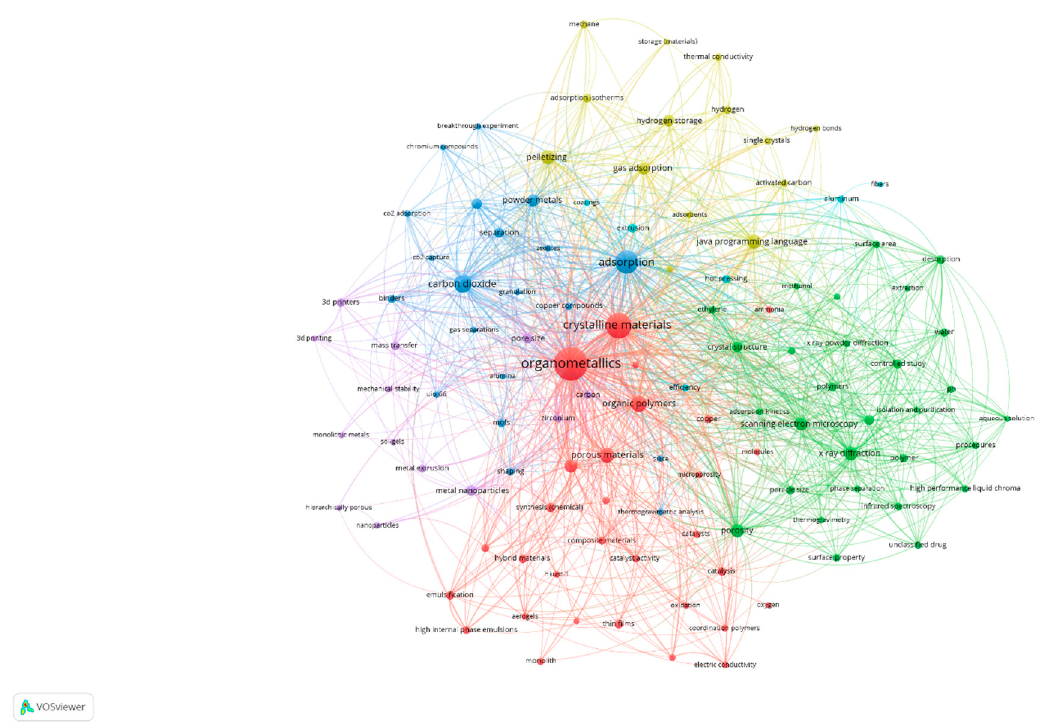
Figure 2. Clustering of keywords set by the authors, and words found in the selected articles’ titles and abstracts. (Source: https://www.vosviewer.com/, accessed on 24 January 2022).